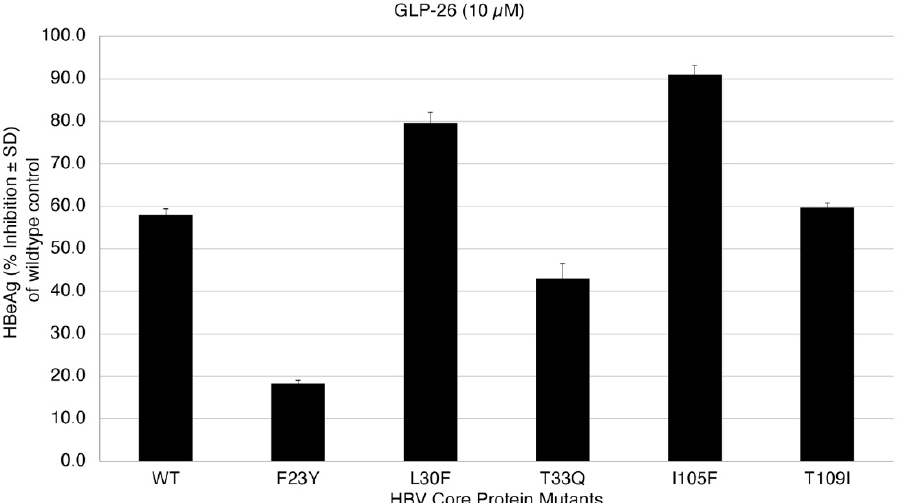
Figure 5. Inhibition of HBeAg secretion in HBV wild-type and core protein mutants at 10 µM GLP- 26. Table 3. Experimental results for the selected mutations in HBV core protein for GLP-26.